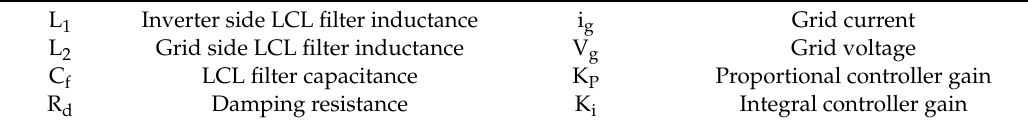
Table 1. Definition of variables in a GCI current control system.